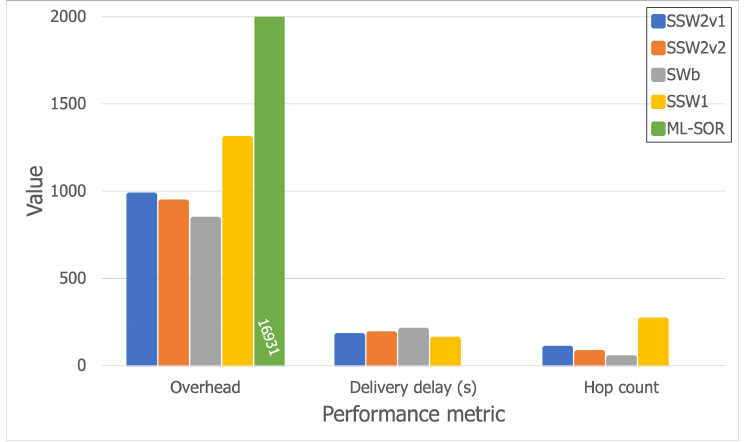
Figure 12. Results for the larger Bluetooth